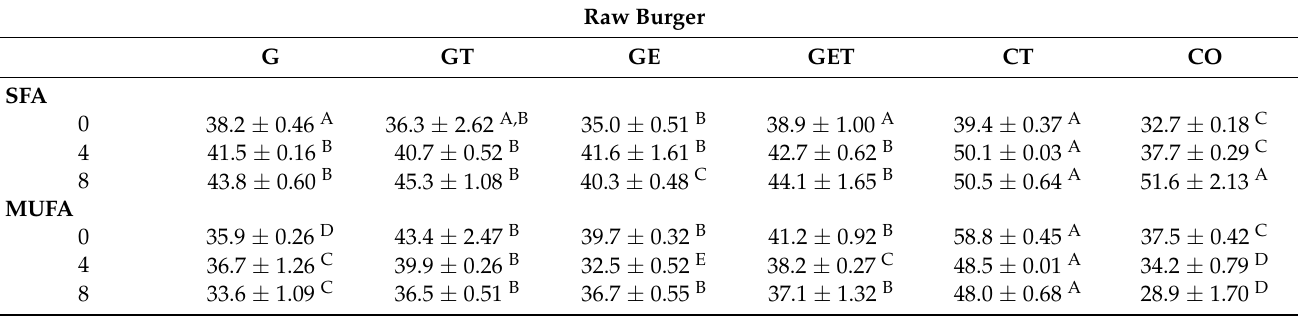
Table 7. Effects of a fat substitute (hydrogel emulsion with encapsulated oil and acai extract) on the fatty acid profile of raw and grilled burgers at 0, 4, and 8 days of storage in cold conditions. Raw